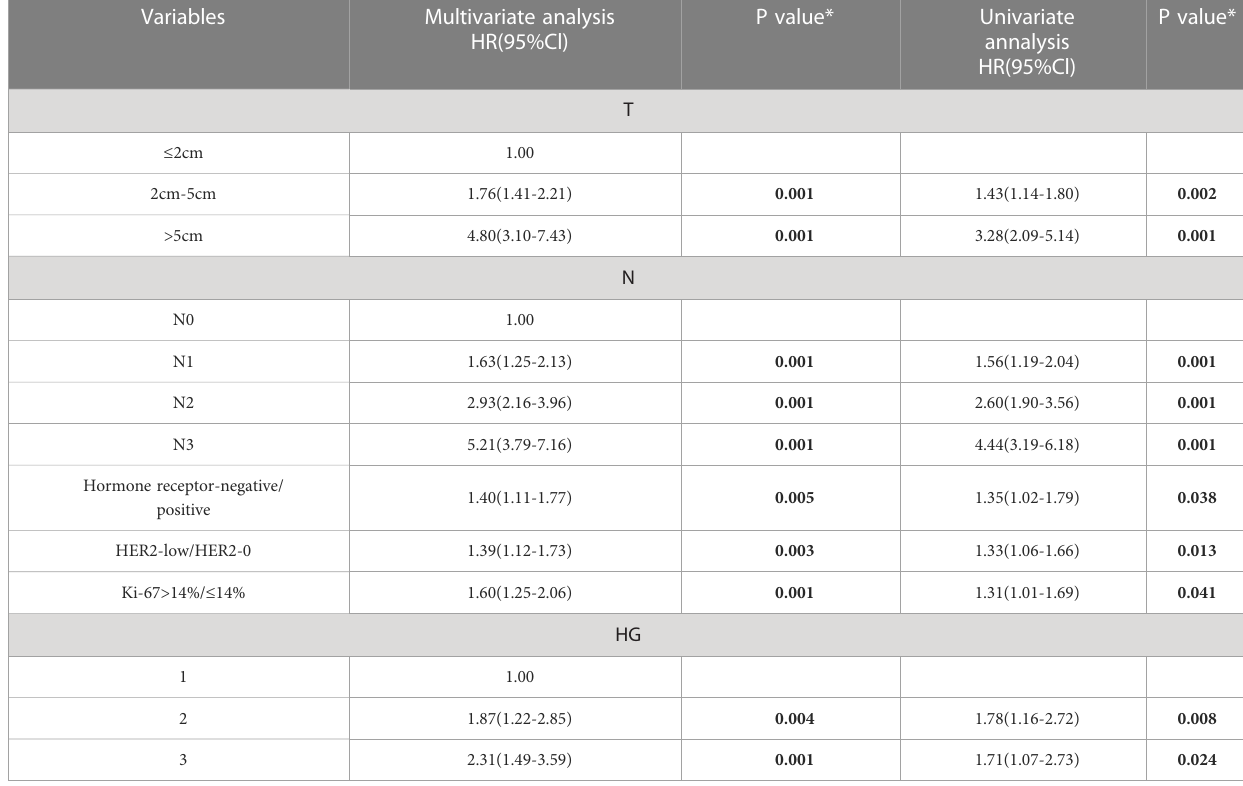
TABLE 2 Univariate and multivariate analyses for disease-free survival in the overall population.